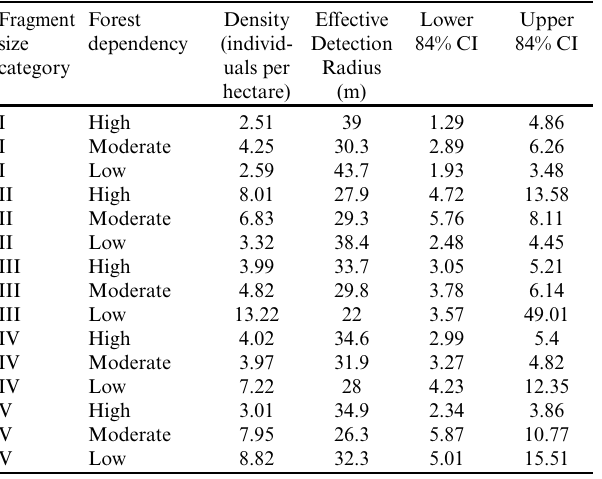
Table 2 . Estimated bird densities, with 84% confidence intervals (CIs), for avian species grouped by three categories of forest dependency in each of the five cloud forest fragment size